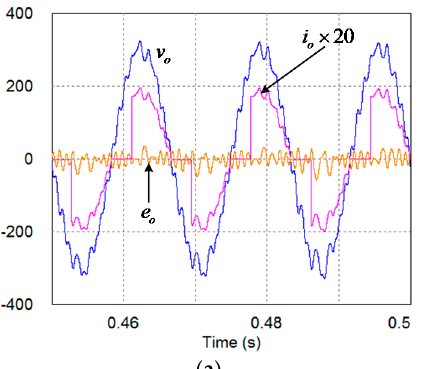
Figure 13. Simulation results of the UPS system with different load configurations.